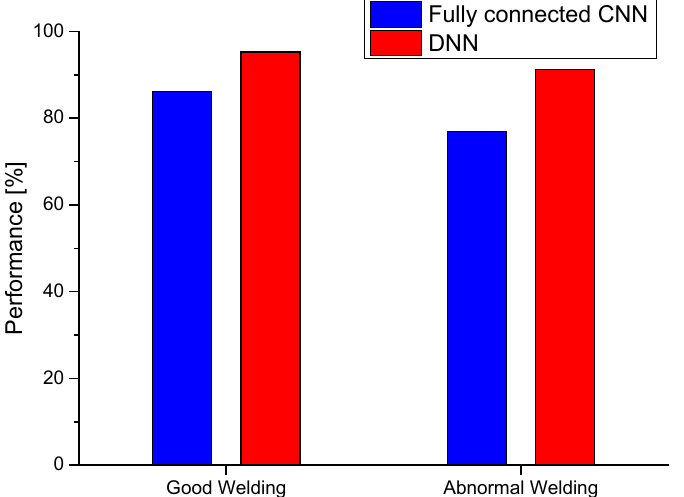
Figure 11. Comparison of the classification results using the fully connected DNN and CNN for ultrasonic signals reflected from the electrode in lithium-ion ultrasonic signals reflected from the electrode in lithium-ion batteries.